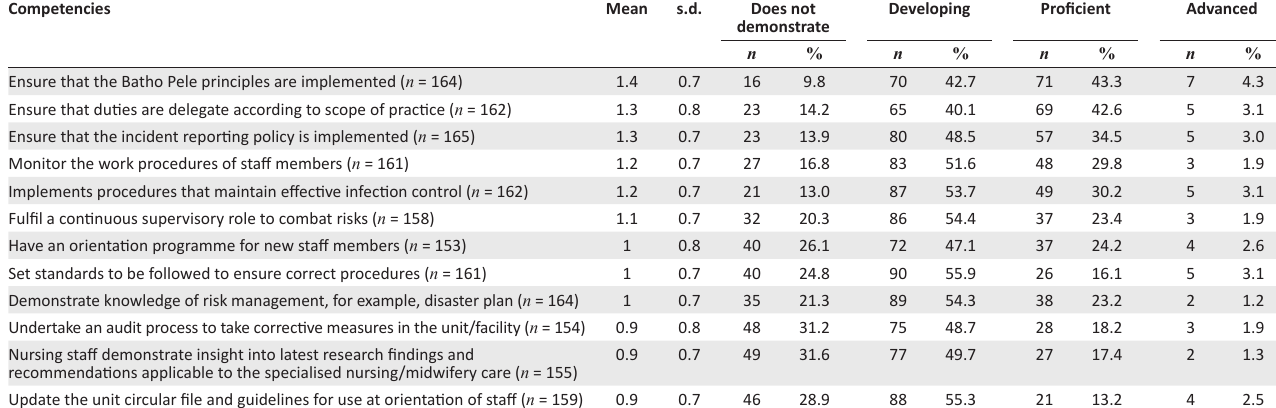
TABLE 6: Competence rating for quality management. Competencies